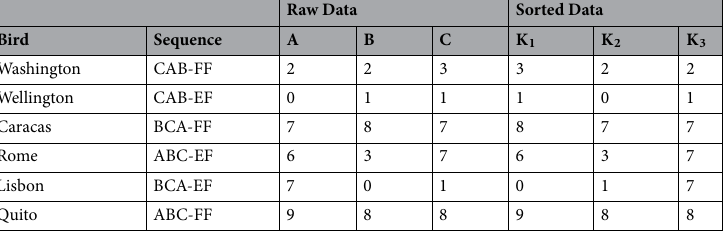
Table 2. Number of items cached in Experiment 2. Raw data and semantically sorted data (K1 = compartment available on trials 1, 4, 7; K2 = compartment available on trials 2, 5, 8; K3 = compartment available on trials 3, 6, 9). The entries in the Sequence column indicate the temporal order of compartments and the group (Food- First group, FF; Empty-First group, EF) during the experience phase, e.g. BCA-EF means that the bird was in compartment B on trials 1, 4 and 7 and received no powdered food on odd days and powdered food on even days.